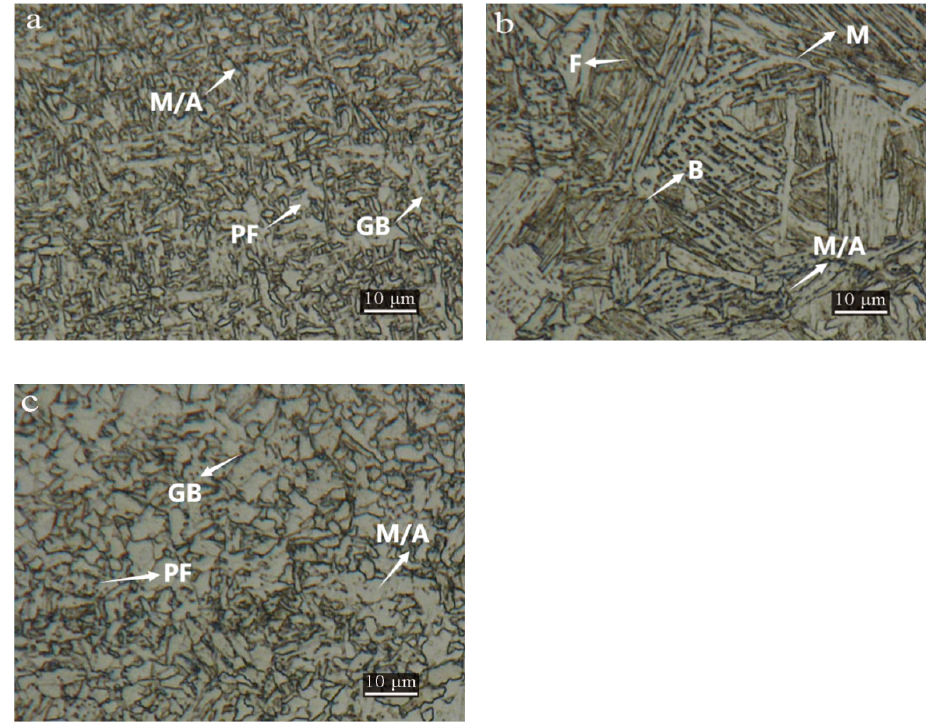
Figure 6. Microstructure of the X80 pipeline steel welded joint with the heat input of 6.67 kJ/cm: ( a ) welded metal; ( b ) CGHAZ and ( c ) FGHAZ.